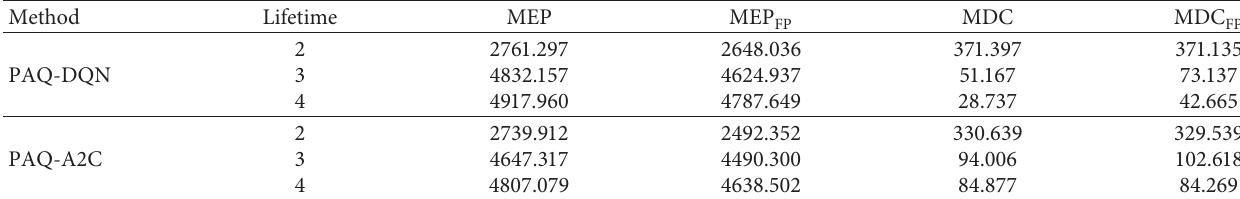
Table 11: Results for dynamic pricing with positive lead